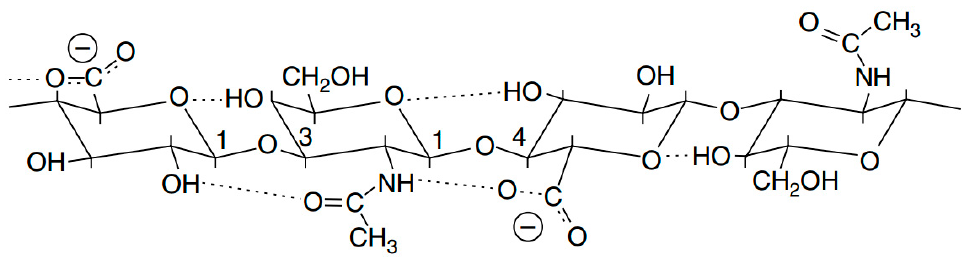
Figure 1. The schematic representation of hydrogen bond formation [33]. Copyright © (1999) National Academy of Sciences. Reproduced from [17], with permission from John Wiley and Sons, 2020